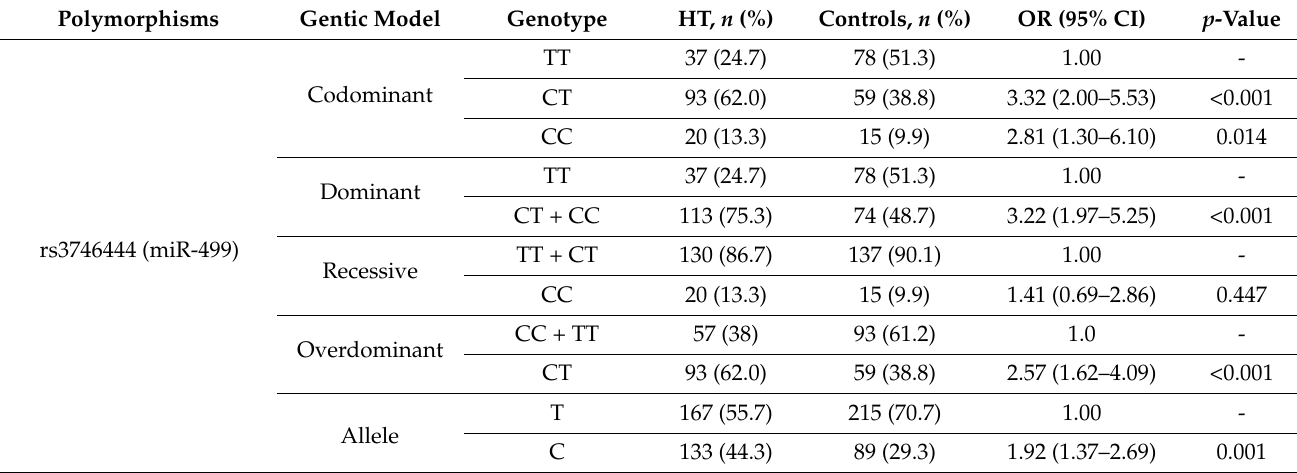
Table 2. The genotype and allele frequencies of miR-499 rs3746444 T > C polymorphism in Hashimoto thyroiditis (HT) patients and control